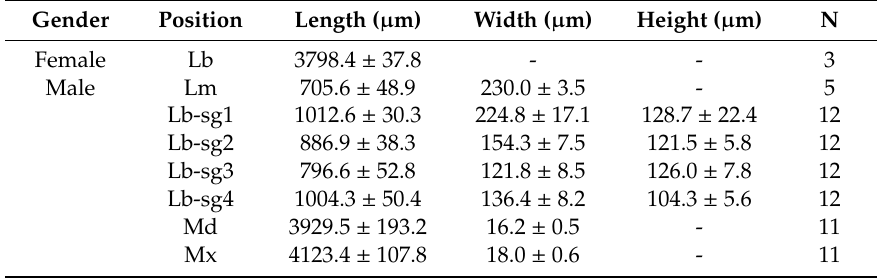
Table 1. Measurements of labrum, labium, and stylets (mean ± SE) of male and female obtained from scanning electron microscopy. N = sample size. Lb-sg1, the first segment of labium; Lb-sg2, the second segment of labium; Lb-sg3, the third segment of labium; Lb-sg4, the fourth segment of labium; Lm,